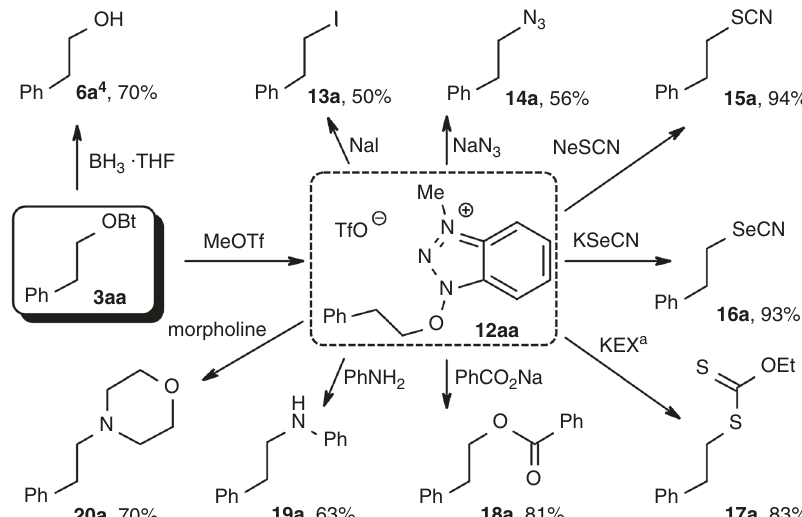
Fig. 3 Activation and derivatisation of 3aa. a KEX = potassium ethyl xanthate.